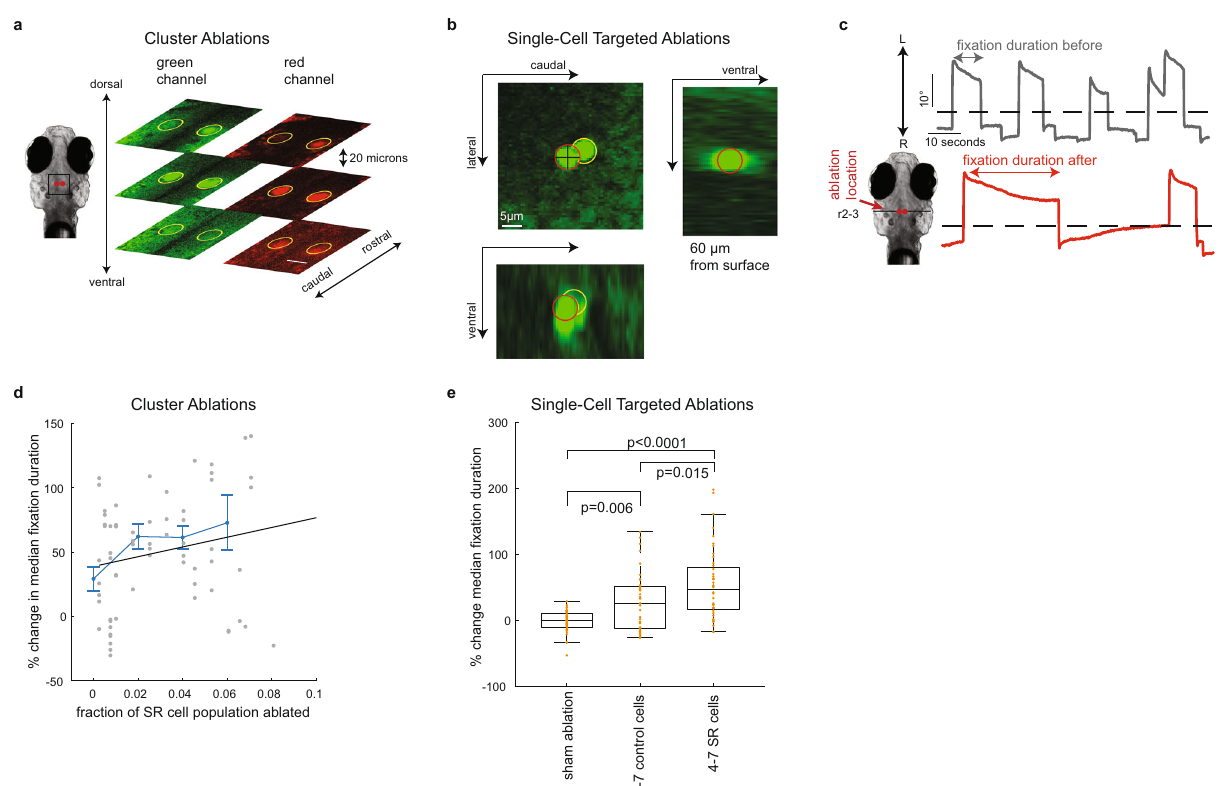
Fig. 7 Focal laser ablations of SR neurons result in increased fi xation durations. a Time-averaged images from an individual fi sh following bilateral laser ablations of clusters of cells. Ablated regions in each plane appear as bright, multi-spectrum fl uorescent regions (outlined in yellow). Similar results were seen in 32 independent cluster ablation experiments. Scale bar is 30 µ m. b Time-averaged images taken from an individual fi sh following a single-neuron ablation attempt (targeted cell outlined in red, off-target ablated cell outlined in yellow). Similar results were seen in 20 independent single-cell ablation experiments. c Example left eye position versus time recorded before (gray) and after (red) a bilateral cluster ablation was performed in the rostral hindbrain (r: rhombomere). The arrows labeled L/R indicate the direction of leftward/rightward movements. d Each gray point shows the percent change in median fi xation duration following cluster ablation from a single animal (best- fi t line shown in black). Blue line shows mean ± SEM of points (bin size = 2% fraction ablated; n = 82 points sampled from 29 fi sh; each point constructed with n = 57 samples, see “ Methods ” ). Pearson correlation coef fi cient for the points shown here equals 0.19. e Percent change in median fi xation duration following single-cell targeted ablations (individual samples shown in orange). For comparison, the boxplot labeled sham ablation shows percent changes in median fi xation duration from non-ablated animals, using randomly selected fi xations to form the sham before and after groups. Two-sample, two-sided, t test p values are displayed above boxplots. All p values displayed are signi fi cant at level 0.05 (using Bonferroni correction to control for family-wise error rate). Mean ± SEM percent change in median fi xation duration equals 54 ± 8% ( n = 44 from ten animals), 28 ± 7% ( n = 40 from ten animals), − 2 ± 3% ( n = 40 samples from 40 animals) following SR, control, and sham ablations. Central line shows the median, box limits show the 25th and 75th percentiles, whiskers show 1.5 × interquartile range about upper and lower quartiles. Source data are provided in a Source data fi we measured the effect on fi xation duration after ablating single SR neurons.